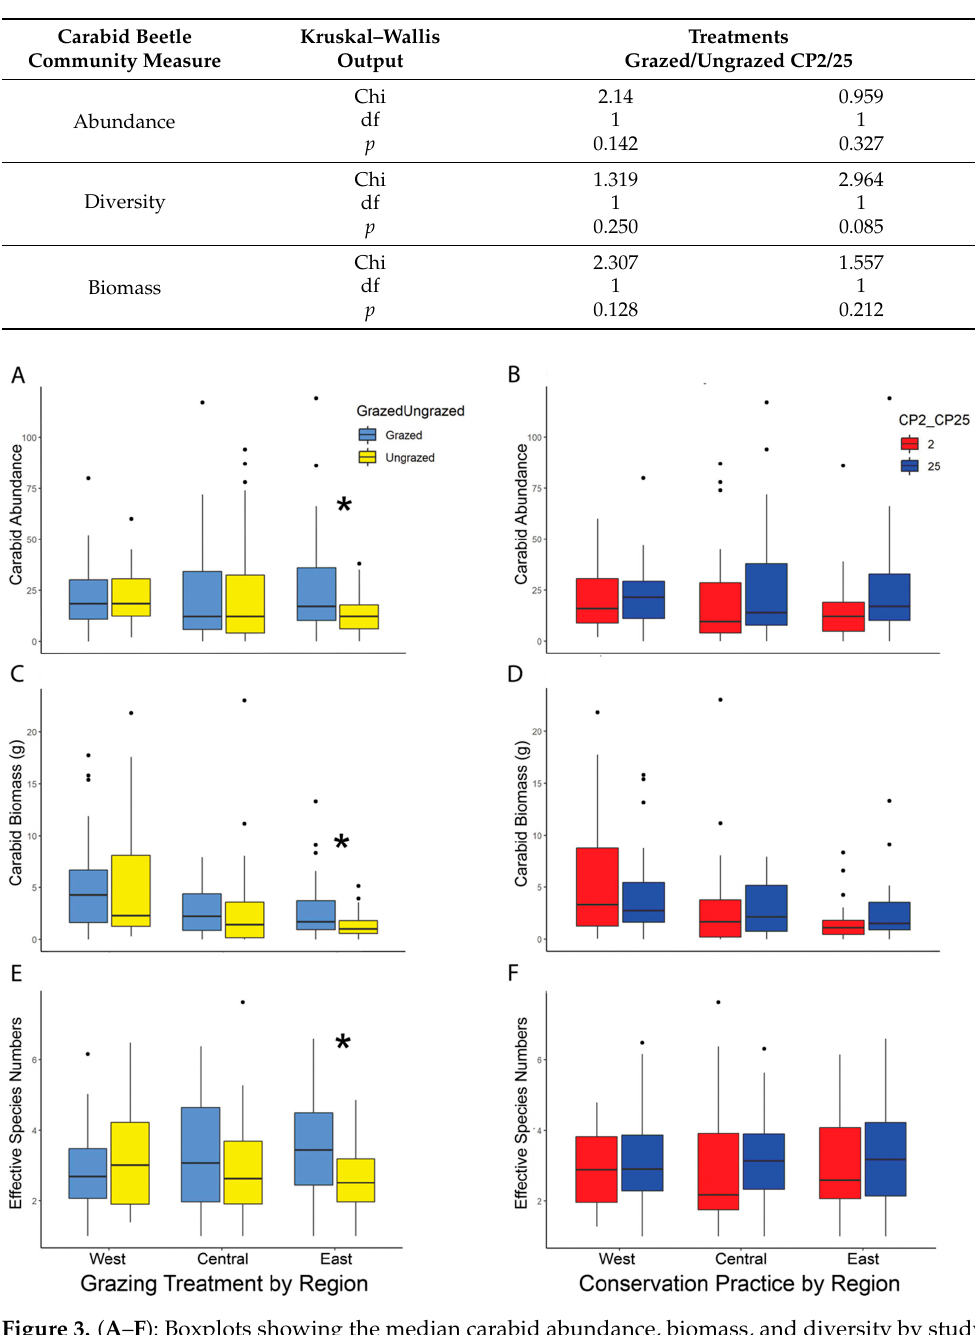
Table 2. Kruskal–Wallis results for overall (across regions) carabid beetle community measures, treatments, and year. There were no significant differences between treatments ( p ≥ 0.05).